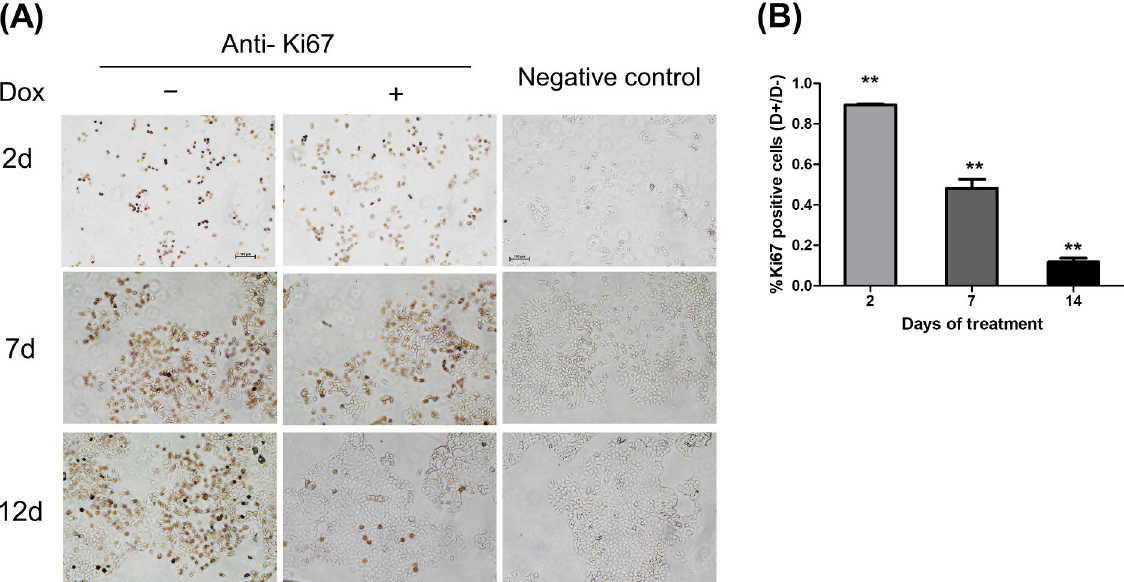
Fig 3. COL17 effect on Ki67 reduction. MCF7/COL cells were grown in 24 well-plate and treated with 0.1 μ g/ml of doxycycline (Dox, D+) or not treated (D − ). Cells were fixed and subjected to immunocytochemistry to observed Ki67 expression at 2, 7, and 14 days of treatment. ( n = 3 biological replicates). (A) The time-course representative images of COL cells blotted with anti-Ki67 or without primary antibody as negative controls. (B) The number of Ki67-positive COL cells was quantified by ImageJ software. The percentage of Ki-67 positive area was normalized by the total number of cells (3 independent areas per sample, 3 samples per group), and displayed as ratio of the normalized expression between D+ and D − groups. Two-tailed Student’s t -test; �� P < 0.01, ��� P < 0.0001; ns, P � 0.05.